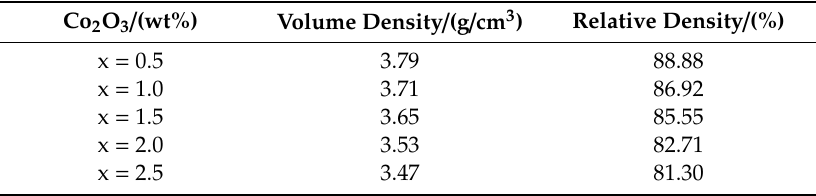
Table 1. With the increase of cobalt content, the density change value of Mg-based lanthanum hexaaluminate.